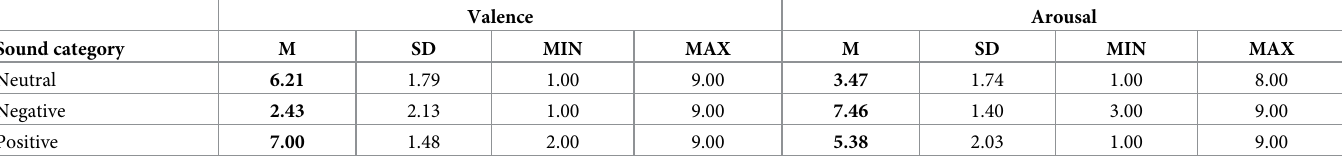
Table 1. Descriptive statistics of the SAM-ratings across stimulus